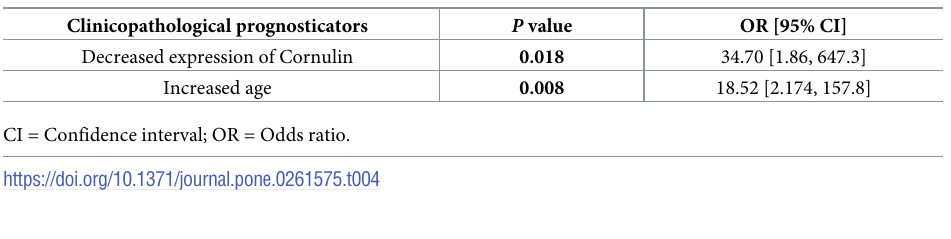
Table 4. Predictor coefficients for the model predicting OSCC